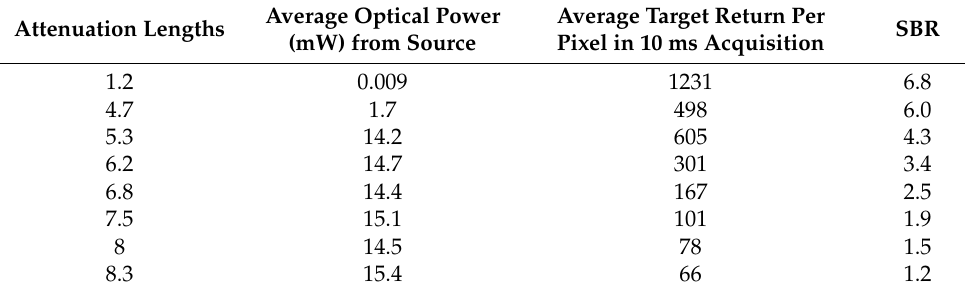
Table 2. Average target return per pixel and signal-to-background ratio (SBR) for the scans shown in Figure 5. The averages were calculated by considering the central 8 SPAD detectors for those pixels coincident with the